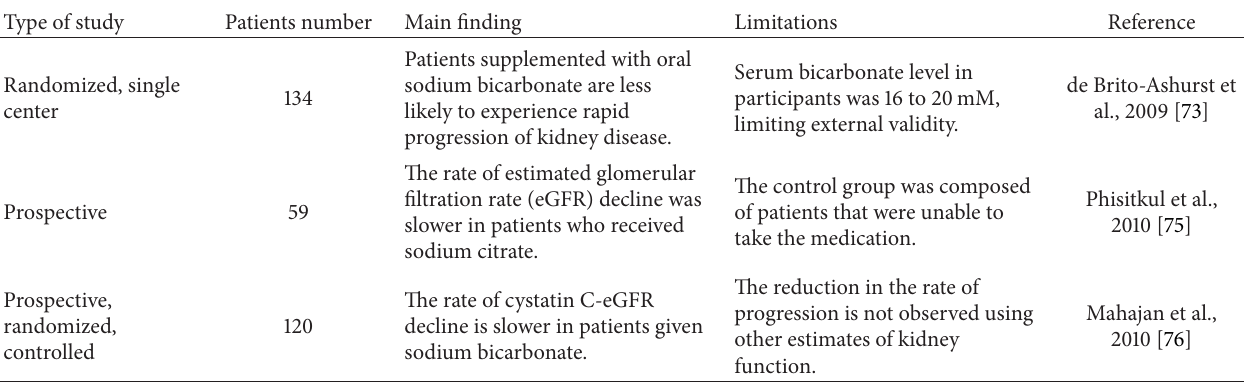
Table 3: Influence of sodium bicarbonate therapy on chronic kidney disease